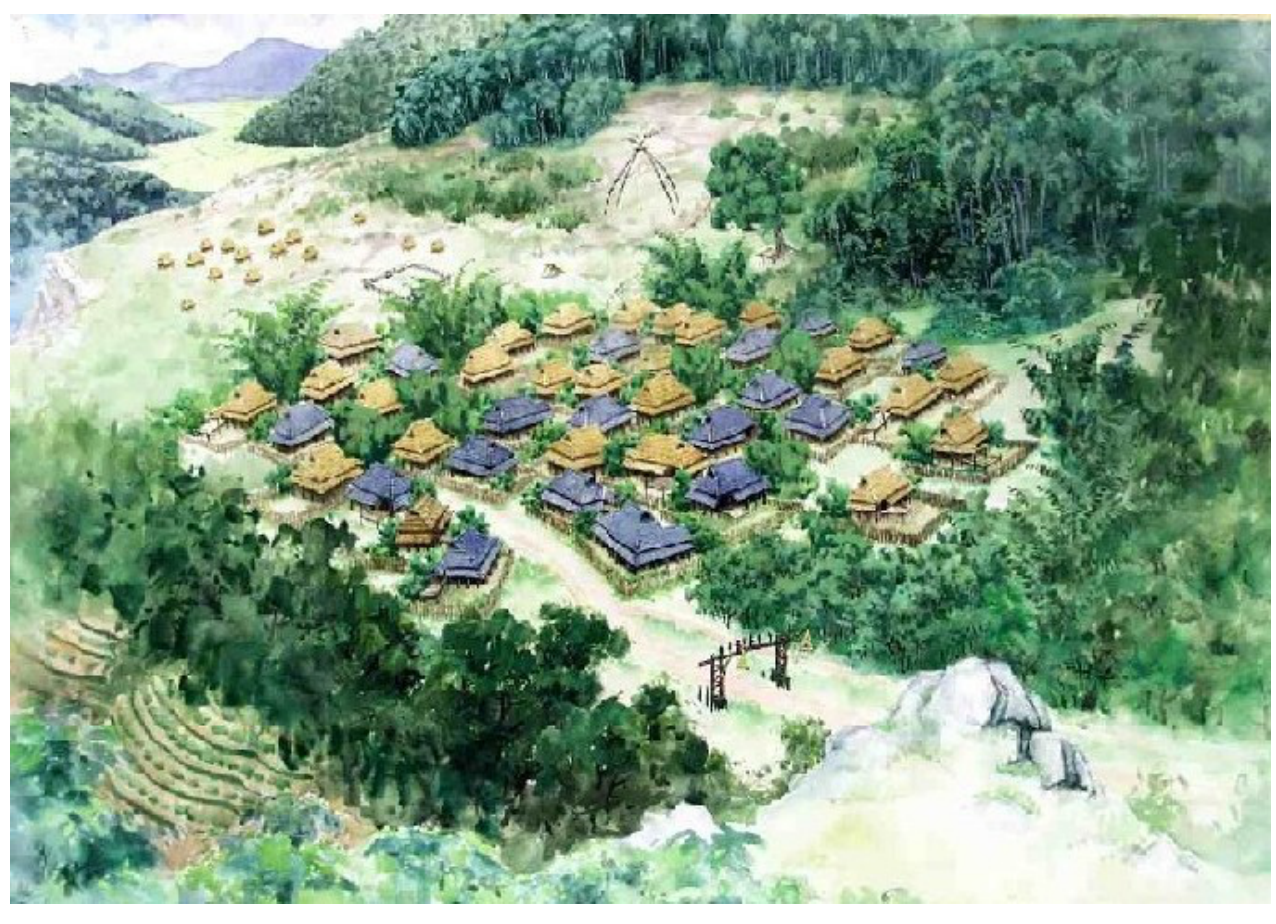
Fig. 3. The physical layout of a Hani village reflects the community’s beliefs. Areas for human habitation are alongside outer areas of forest preserved for the souls of departed ancestors and gods. The village gate in the foreground separates society and nature, while the common house, in the center behind the gate, allows communication among the different facets. Illustration by Yang Jiankun, Kunming Institute of Botany, Kunming,